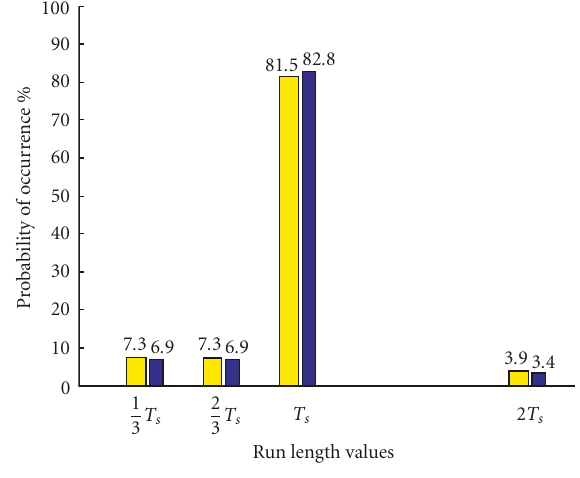
Figure 7: Histogram of the run lengths of a BOC(7,3) signal of du- ration 1ms (corresponding to 3069 code chips). The lighter bars account for the computed experimental probabilities, whereas the darker bars make up for the theoretical